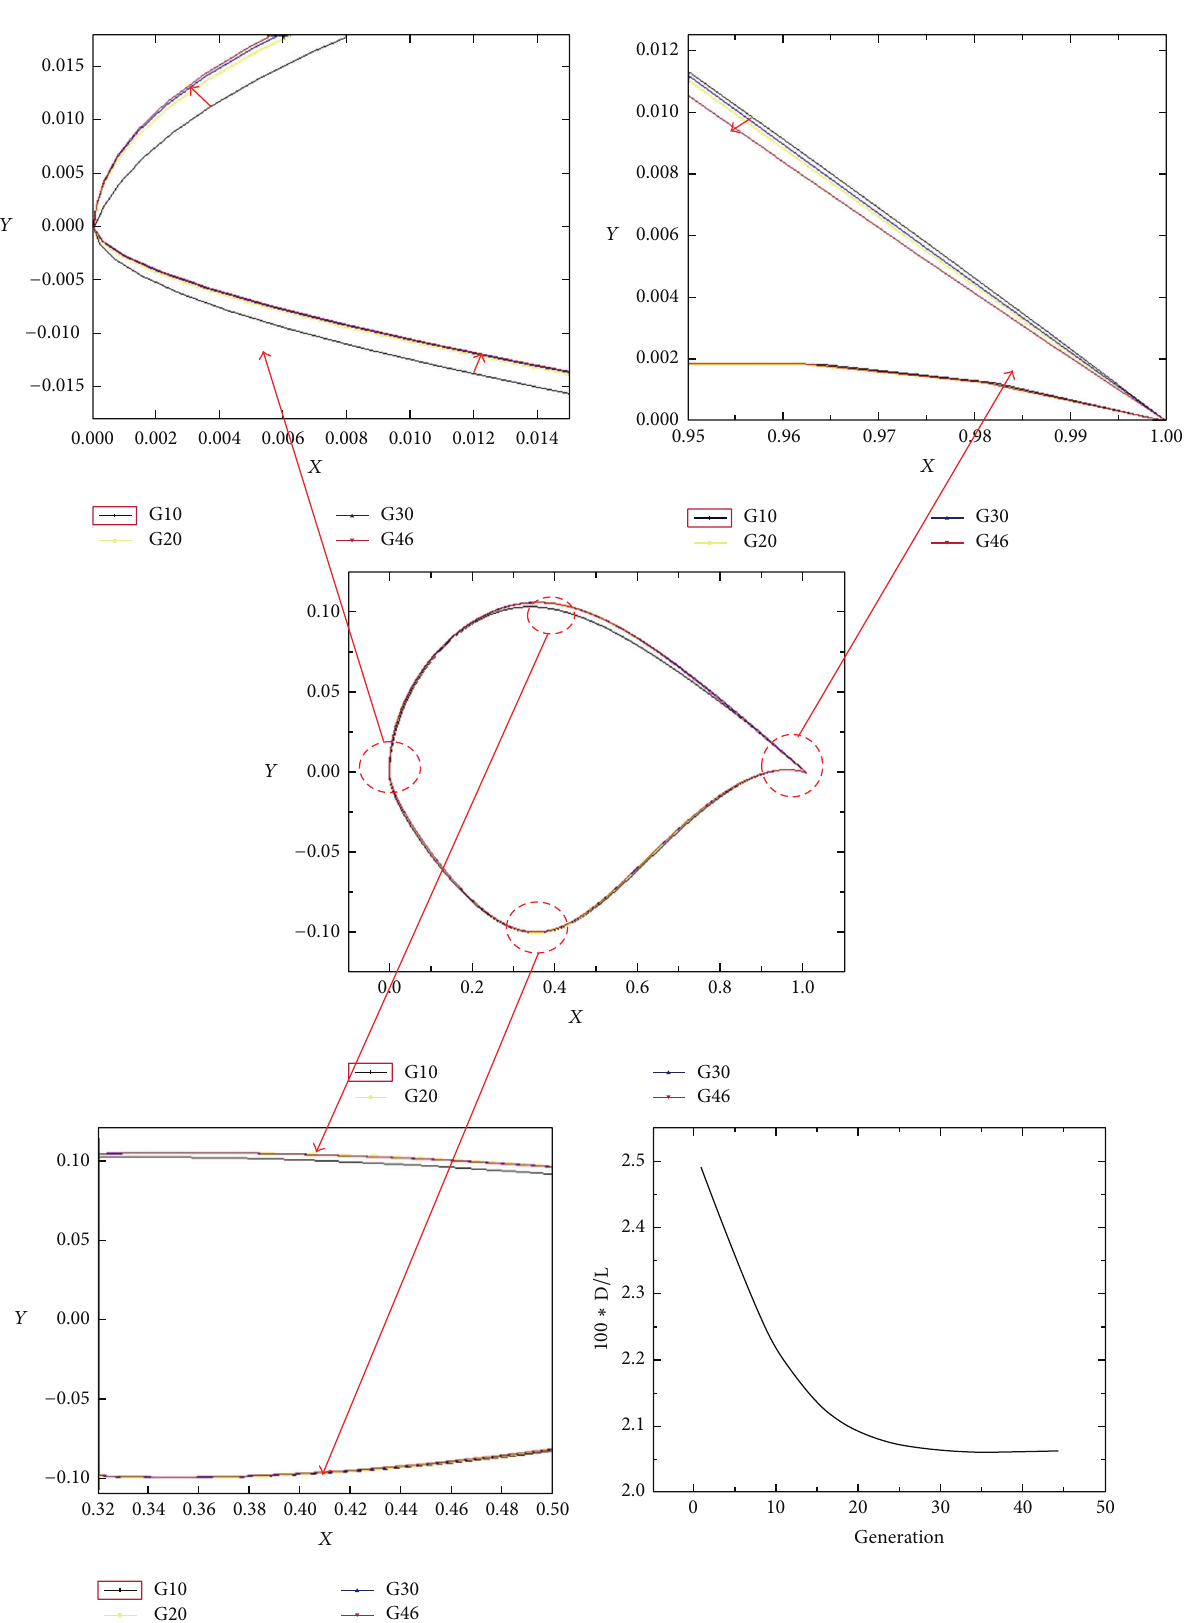
Figure 7: Shape evolution of airfoil and variation in drag to lift ratio at 23% span location in various generations of